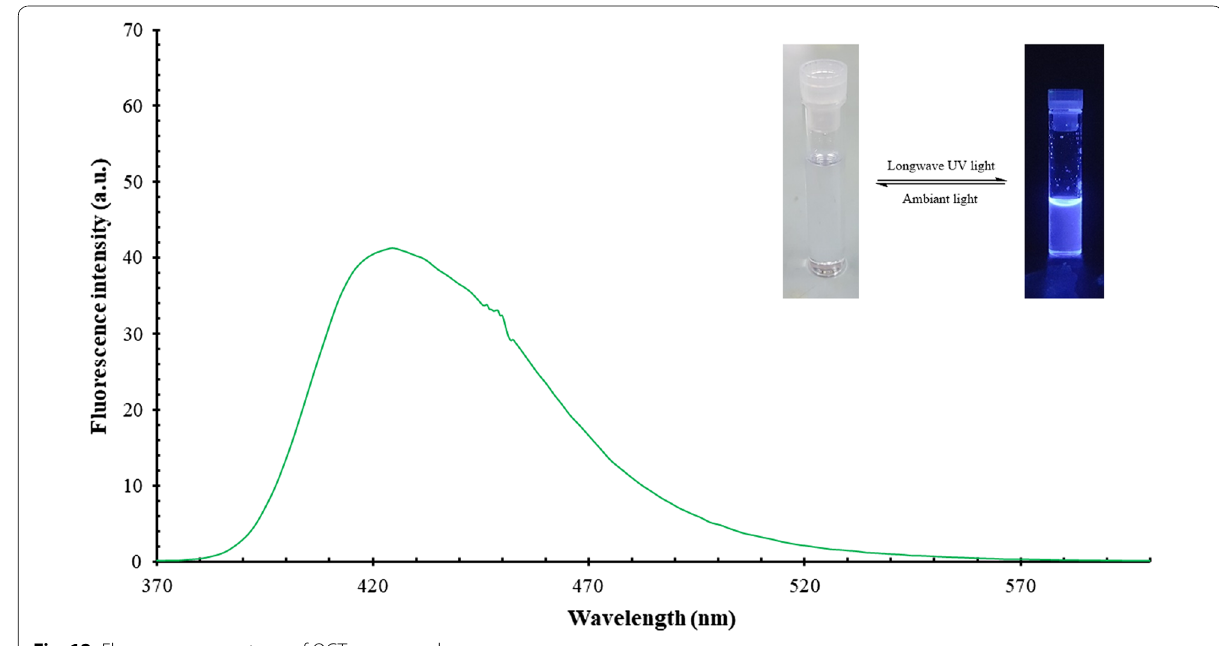
Fig. 12 Fluorescence spectrum of OCT compound